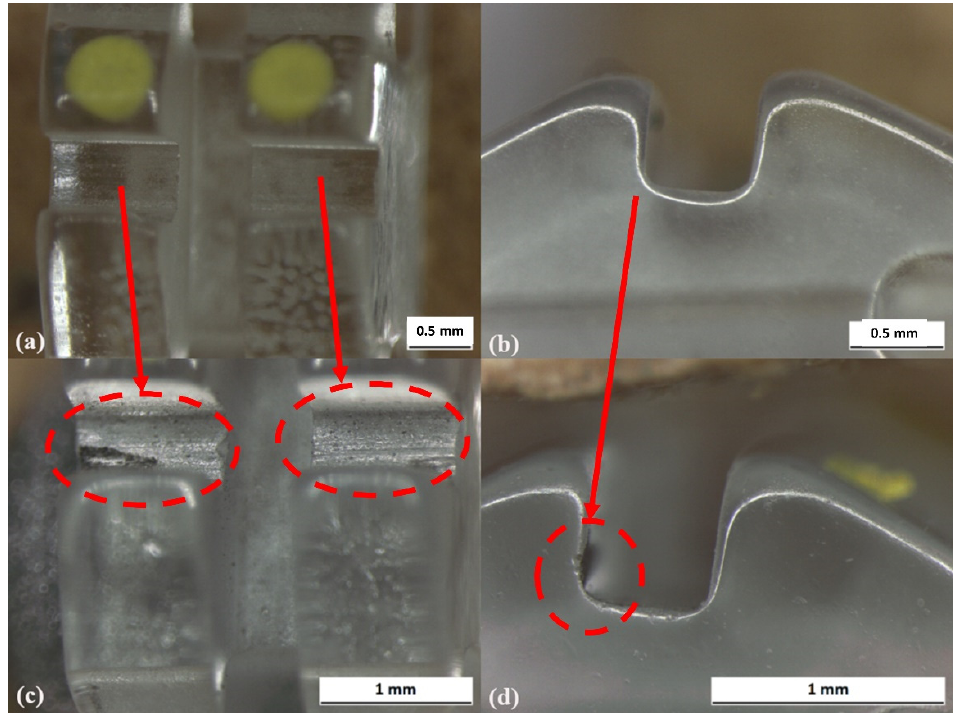
Figure 2. Zephyr bracket (Micerium Orthodontics) in top and side view: ( a , b ) before the test; ( c , d ) after the test.